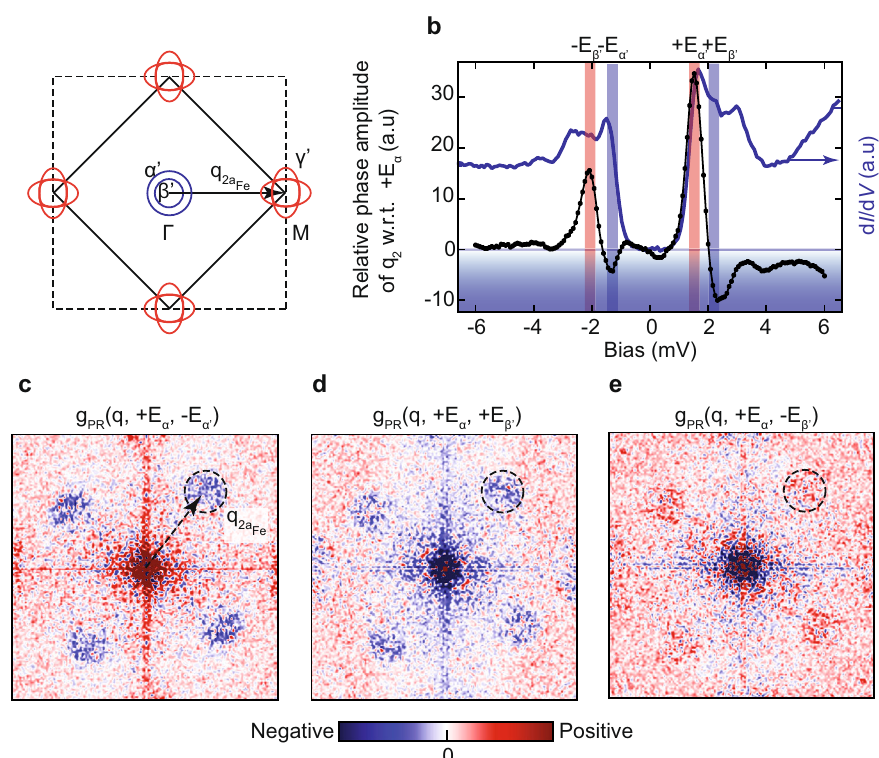
Fig. 4 PR-QPI to show s± pairing and the sign-changes of the order parameter across α ′ and β ′ bands. (Sign change is indicated by blue or red colors). a Fermi surface of an s± superconducting state of Fe (Se,Te) based on the 2-Fe unit cell model. The dashed line indicates the Brillouin Zone in the 1-Fe unit cell model. The q vector of the scattering process observed in our data is labeled as q 2aFe . The red and blue colors indicate the relative sign of the superconducting order parameter. b Plot of the amplitude of the phase (relative to + E α ’ i.e., α ’ band) as a function of energy of the scattering vector q 2aFe (summed inside the dotted region shown in c ) in the phase-reference Fourier transforms of the DOS maps obtained on a 30 nm × 30 nm area. c – e PR-QPI of the scattering vector q 2aFe that connects the α ’ , β ’ and γ ’ bands between various